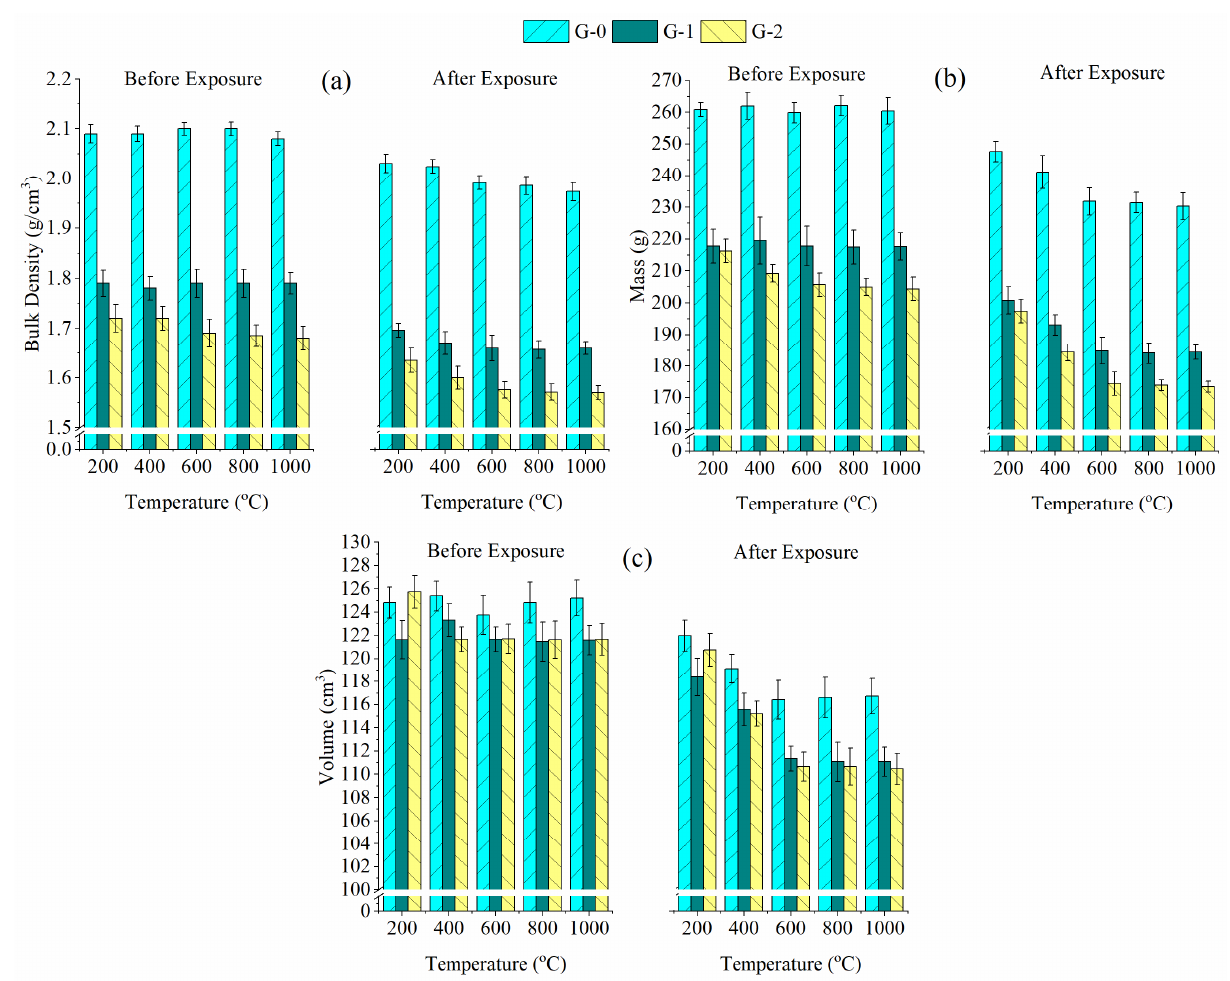
Figure 7. ( a ) Bulk density, ( b ) mass and ( c ) volume of G-0, G-1 and G-2 before and after exposure to high temperatures.